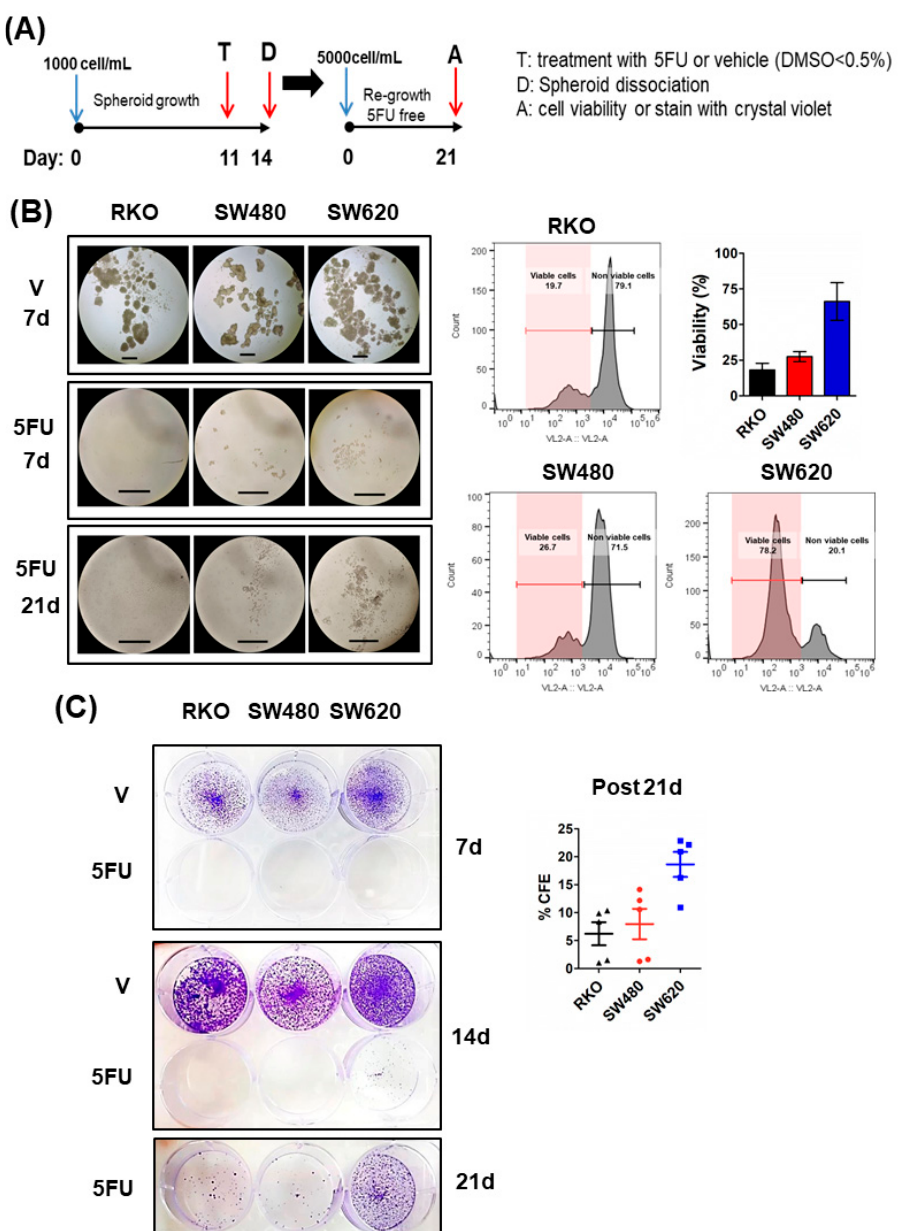
Figure 3. SW620 metastatic cells exhibit an increased capacity for re-grow after 5FU treatment under independent and anchorage-dependent conditions compared to SW480 and RKO cell lines derived from primary tumors. ( A ) Experimental scheme to evaluate the ability of CRC spheroid cells to re-grow after 5FU treatment in anchorage-independent and-dependent conditions compared to cells from spheroids treated with vehicle (V) according to methodology. Spheroids treated were dissociated and seeded to 5000 cells/mL in low-attachment and Tissue culture-treated microplates, respectively. ( B ) Left panel: Photographs of cell cultures in low-attachment microplates on the 7th, 14th, and 21st day of incubation after spheroids dissociation and cell re-seeding (scale bar: 500 µ m). Right panel: Cell viability of collected cells in these cultures was determined using AquaZombie dye on the 21st day of incubation. Fluorescence was measured by flow cytometry. ( C ) Colonies formed in high adherence surfaces (tissue culture-treated microplates) were stained with crystal violet on the 7th, 14th, and 21st days of growth after cell re-seeding. The colony formation efficiency (% CFE) post-5FU treatment was calculated on the 21st day. Images are representative of at least three independent